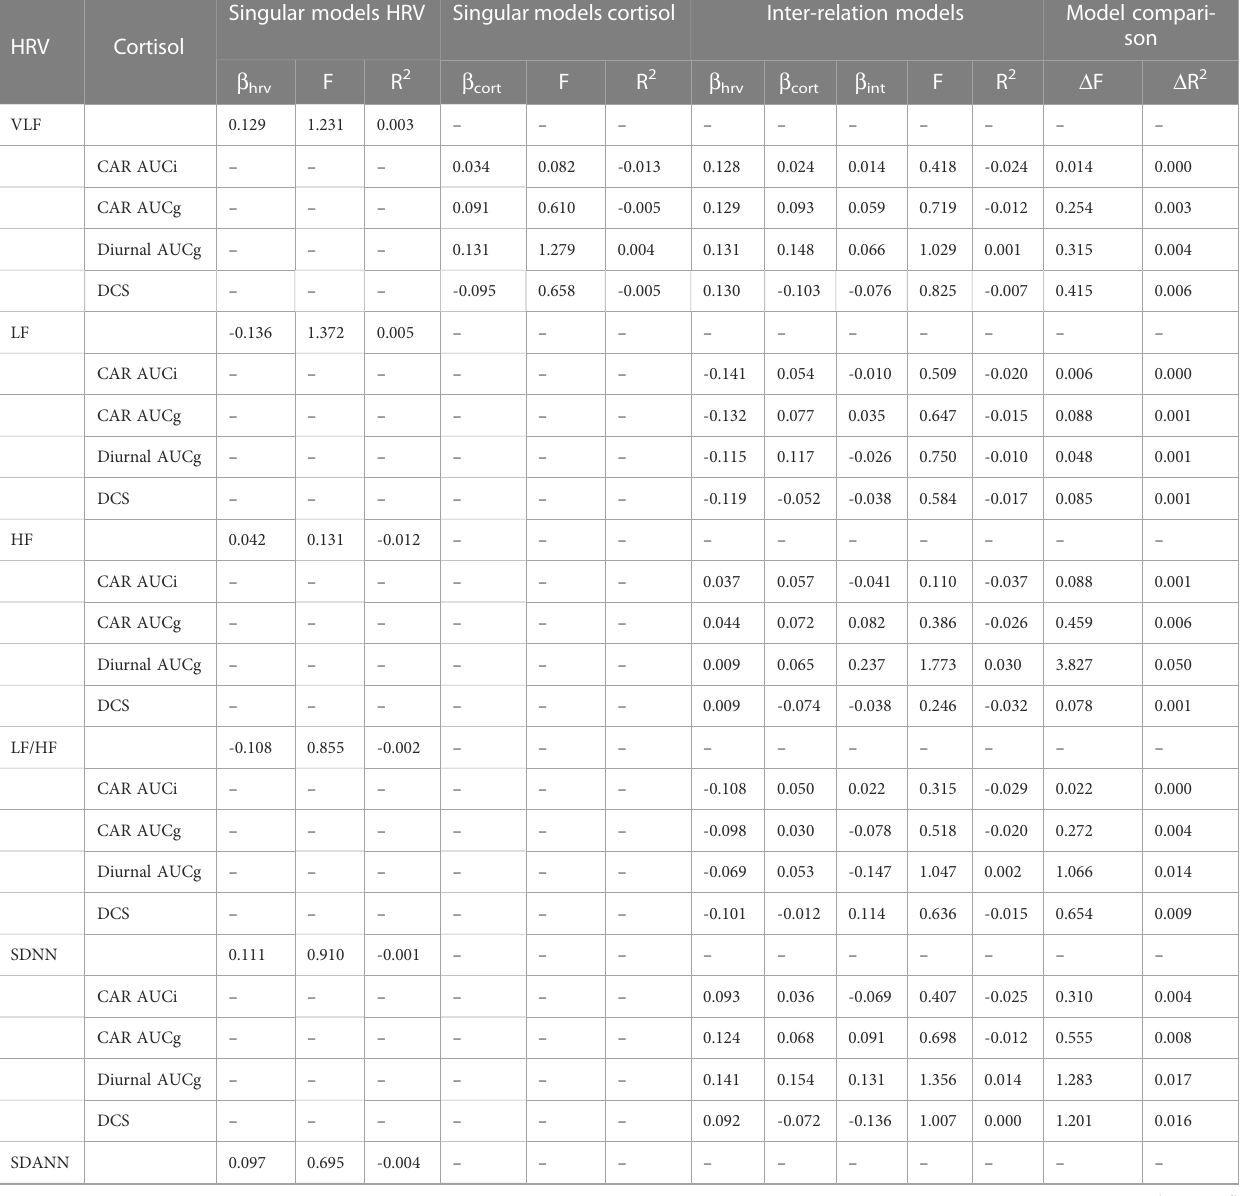
TABLE 3 Singular versus inter-relation model comparisons in healthy men.